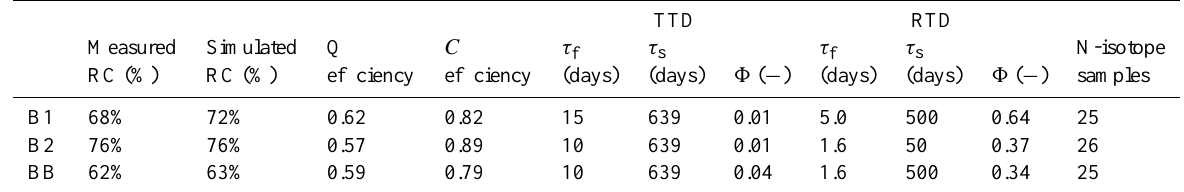
Table 3. Parameters of response and transit time model applied to